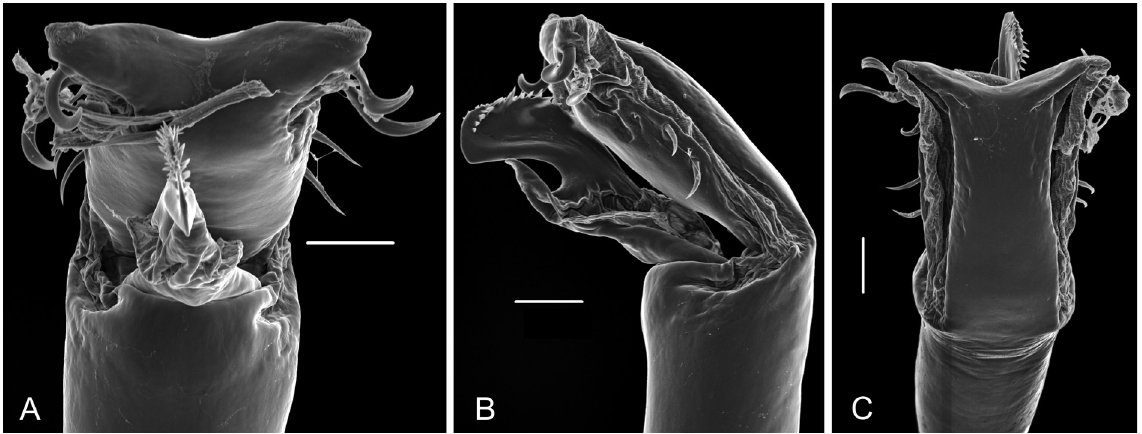
Fig. 26. Eulibitia pollux sp. nov., ♂ (MNRJ 19369), distal part of penis. A . Dorsal view. B . Lateral view. C . Ventral view. Scale bars: 50